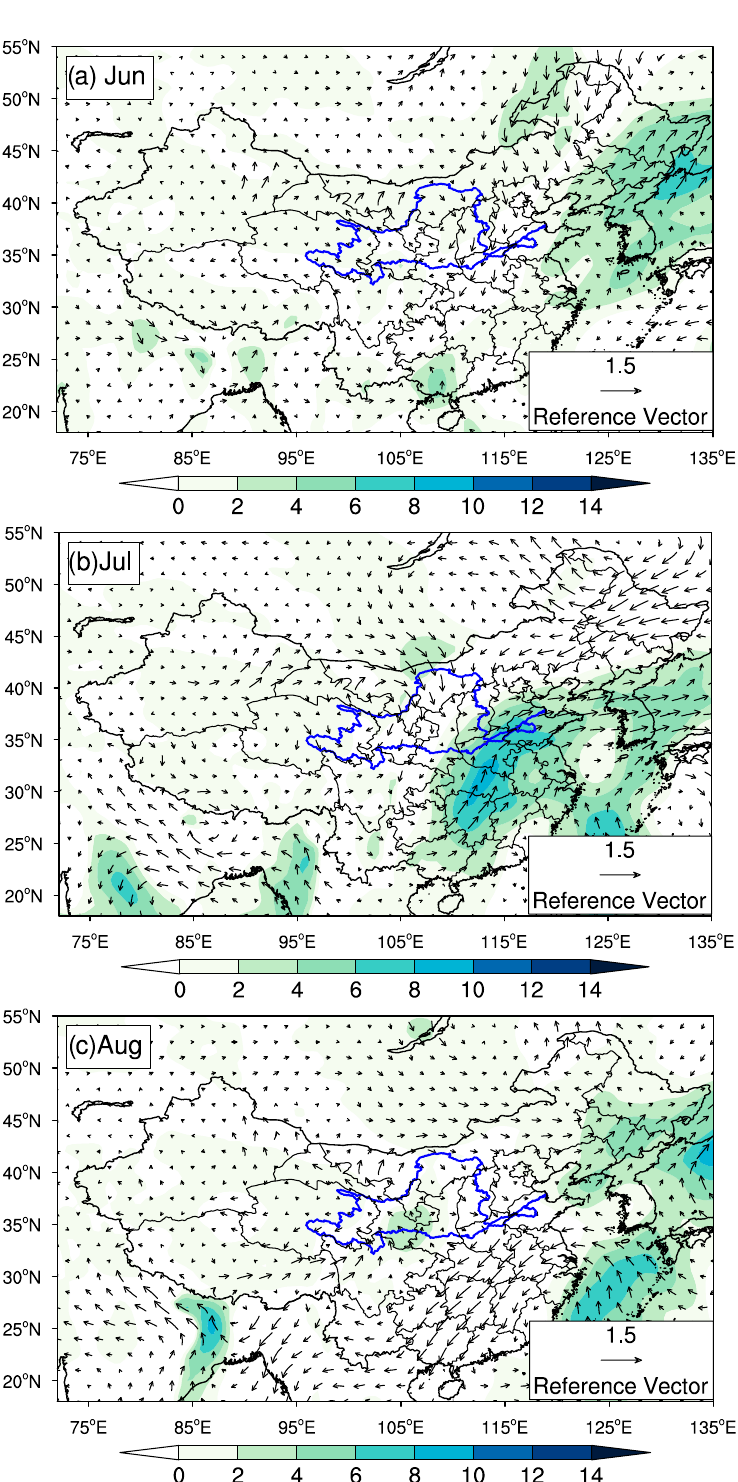
Figure 6. Differences (defined as Y minus N) in the integrated water vapor flux (shading, unit: kg·m − 1 ·s − 1 ) and wind field (vector, unit: m·s − 1 ) at 850 hPa under RCP8.5 from June to August. ( a ) June; ( b ) July; ( c ) August.